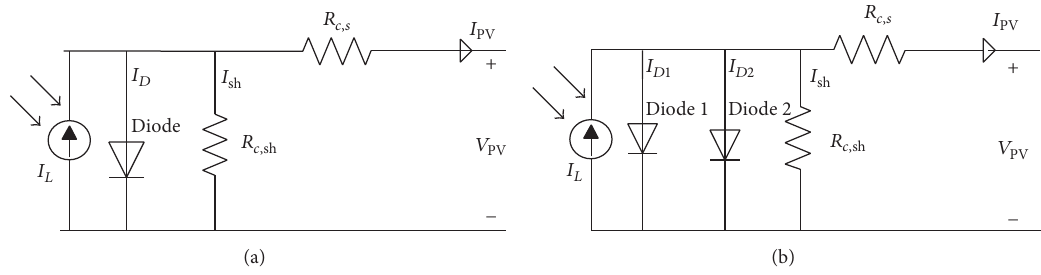
Figure 1: Equivalent circuits for (a) the one-diode model and (b) the double-diode